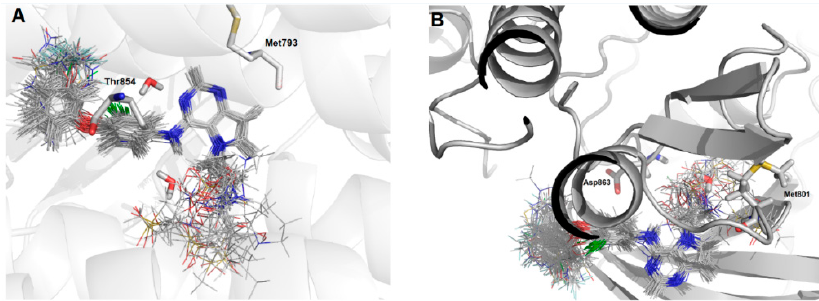
Figure 3. Molecular alignment of the compound set at the active site of: ( A ) EGFR; and ( B ) HER-2.